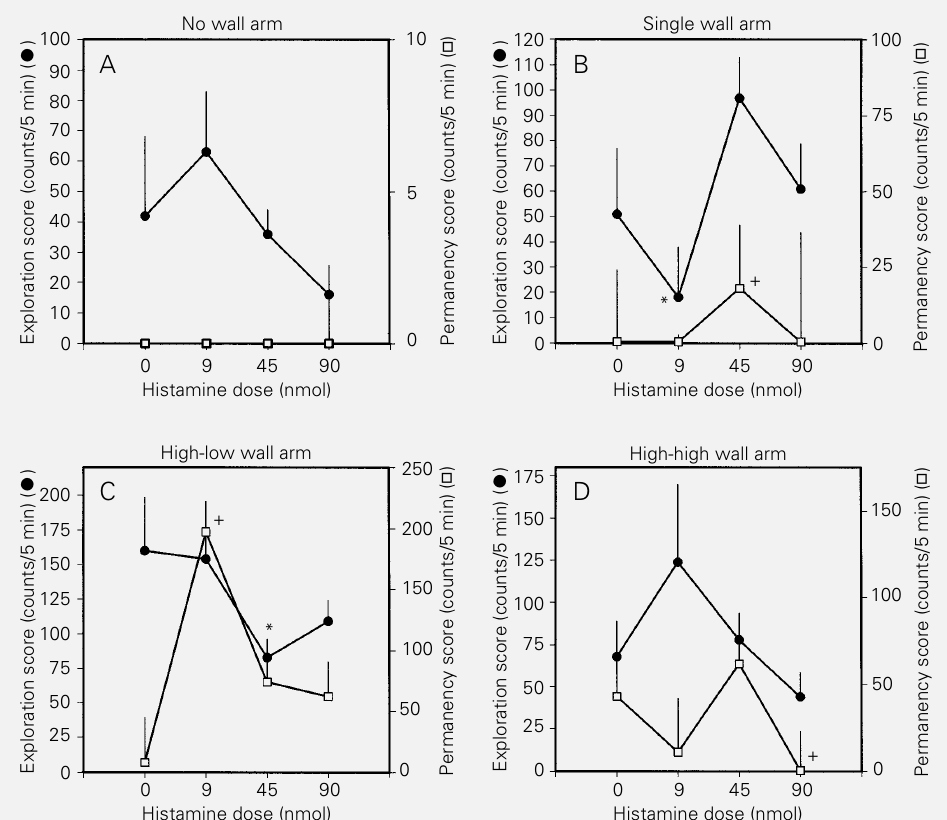
Figure 3 - Exploration and per- manency scores in the asym- metric plus-maze of implanted rats treated with different doses of histamine. Dose “0” (saline group), described in Figure 2, has been included here in order to facilitate comparisons. A , No wall arm. B , Single wall arm: *P<0.05 vs dose “0”, + P<0.01 vs dose “0”. C , High-low wall arm: *P<0.05 vs dose “0”, + P<0.01 vs dose “0”. D , High- high wall arm: + P<0.05 vs dose “0” (nonparametric Dunn